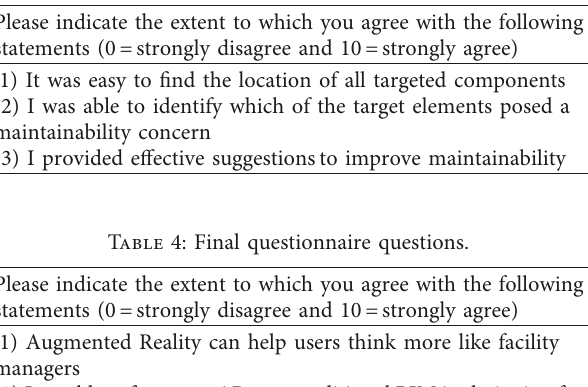
Figure 3: The space used for the augmented reality environment: third person and first person views. Table 3: Postquestionnaire questions.